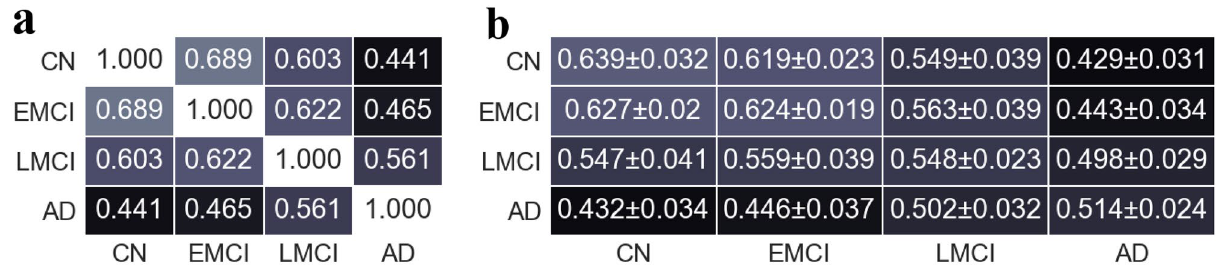
Figure 1. The similarity between study groups follows a trend proportional to the trend of disease progression. ( a ) The Jaccard similarity coefficient between the four main group networks. ( b ) For each study group,